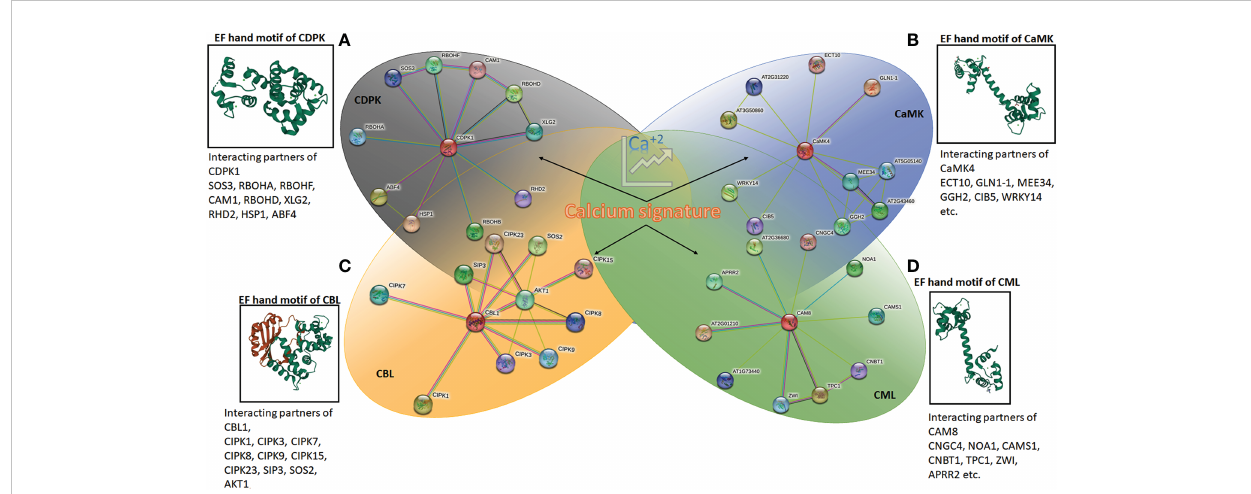
FIGURE 2 The protein-protein interaction network generated using STRING (version 11.5) online server using Arabidopsis CDPK1, CaMK4, CAM8 and CBL1. The details of interacting partners are summarised in Supplementary Excel 1 and 2. The molecular structure of calcium-binding EF-hand motifs is also depicted from different reported protein data bank (PDB) structures. (A) CDPK of Arabidopsis (2AAO) reported by Chandran et al. (2006); (B) CaM7 (5A2H) of Arabidopsis thaliana reported by Kumar et al. (2016); (C) SOS2 interacting with SOS3 (2EHB), CBL of Arabidopsis thaliana reported by Sa ́ nchez-Barrena et al. (2007); and (D) calmodulin, CML (1UP5) from chicken reported by Rupp et al.